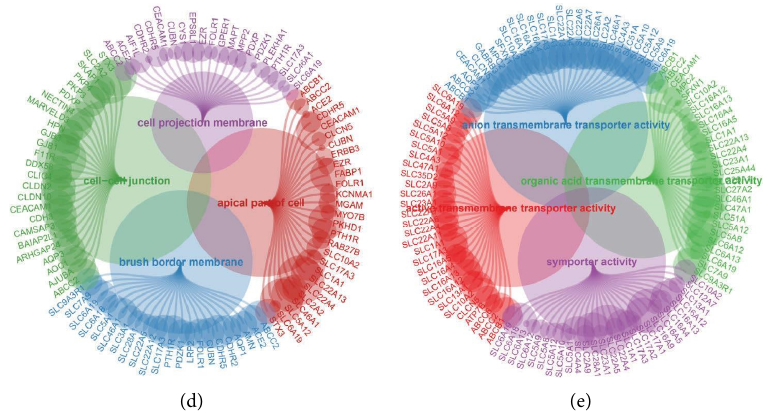
Figure 6: (a) Te results of GSVA based on the HALLMARK enrichment analysis; (b) the results of GSVA based on HALLMARK enrichment analysis; (c) the GO BP enrichment analysis based on genes involved in the MEred module; (d) the GO CC enrichment analysis based on genes involved in the MEred module; (e) the GO MF enrichment analysis based on genes involved in the MEred